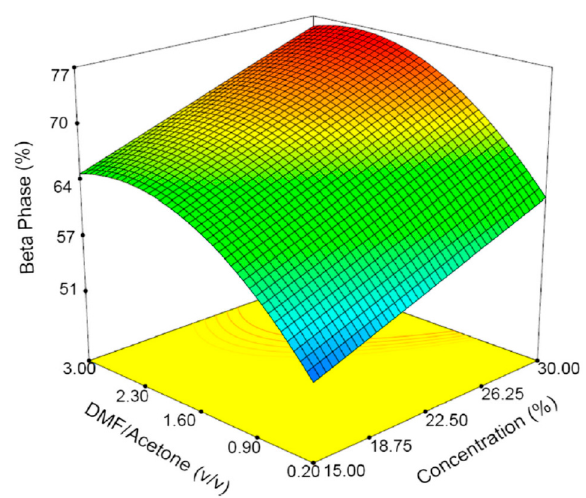
Figure 11. Three-dimensional plots of beta phase content vs. PVDF concentration and DMF/acetone ratio. Reproduced with permission from [124], published by Springer, 2018.